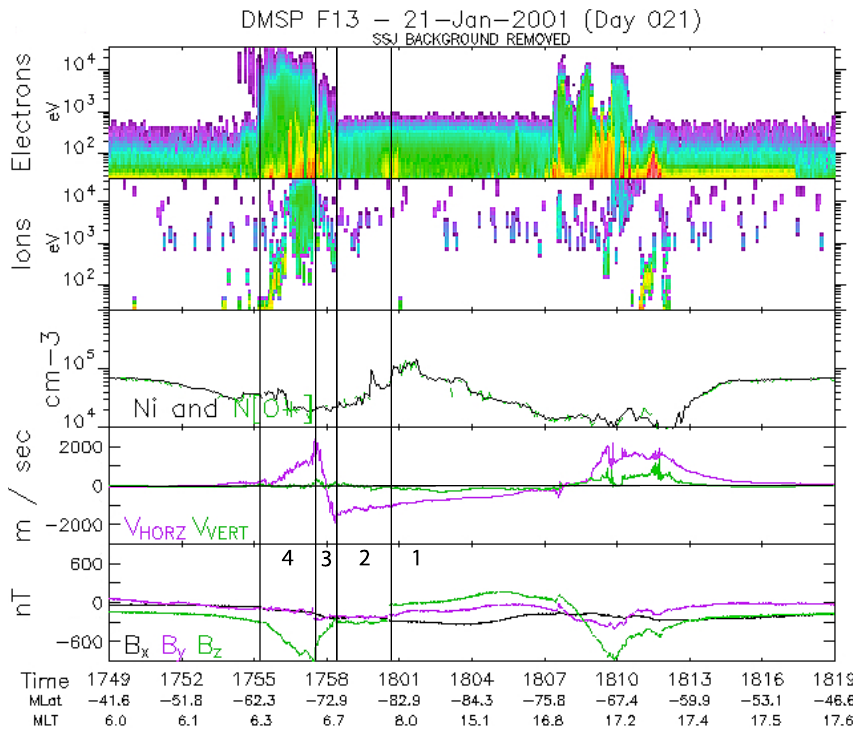
Fig. 22. Southern Hemisphere DMSP F13 data for the interval 17:49–18:19UT. Precipitation/Birkeland current/convection regimes marked are: (1): P.RAIN (central polar cap); (2): P.RAIN and C1 current and FC 2; (3): morning BPS and C2/R1 currents; (4): CPS and R2 current. Event category: SH-dawn/ B y < 0